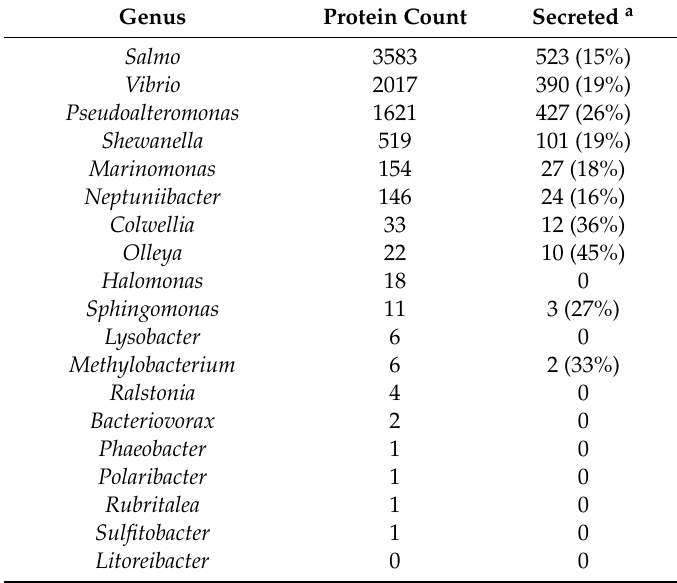
Table 1. The total number of proteins (all the time points) assigned to the di ff erent genera identified by 16S rRNA sequencing (Figure 1) and the amount of proteins predicted as secreted. Genus Protein Count Secreted